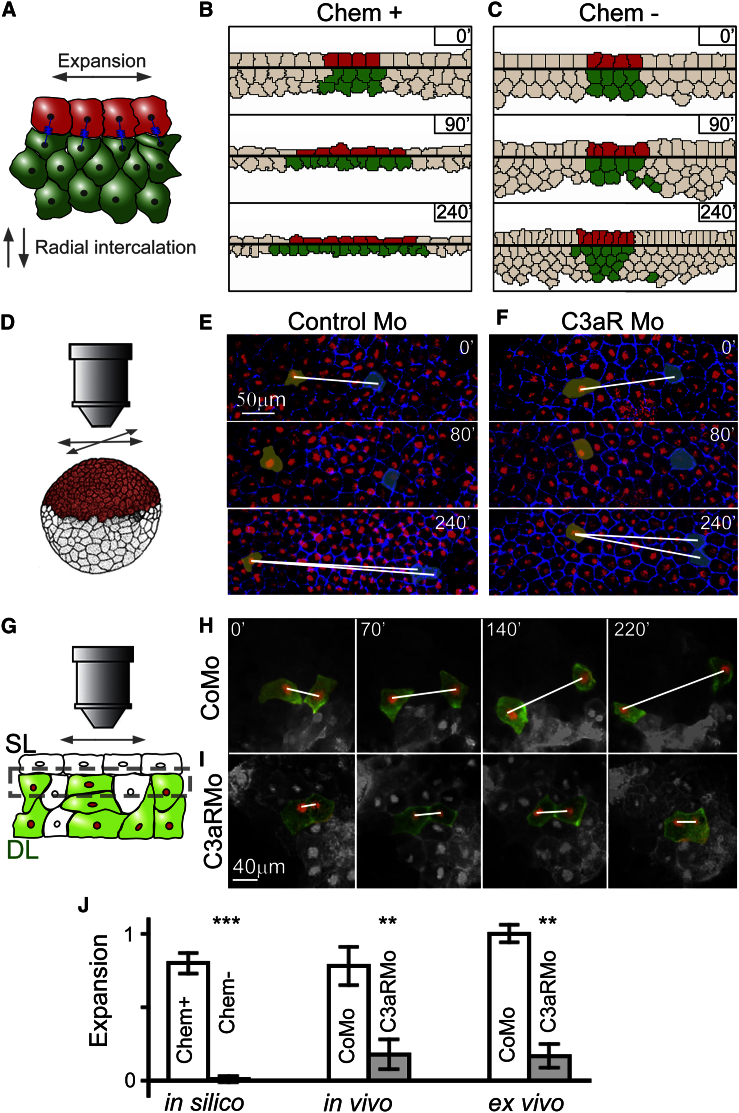
C3 Signaling Is Required for Epithelial Expansion(A–C) Model prediction of tissue expansion as a consequence of chemotaxis-driven RI. In the presence of chemotaxis, both the SL and DL expand simultaneously with RI (B, coloring for visual aid only), while no expansion is observed without chemotaxis (C).(D–F) Time-lapse imaging of epiboly in live embryos (D) reveals that while SCs drift away from one another following CoMo treatment (E), the distance of SCs in C3aR-deficient embryos does not increase (F) during the process.(G–I) Ex vivo study of tissue expansion using the intercalation assay (G). Cells in the DL separate as the isolated tissue undergoes expansion (H). This expansion is lost in tissues lacking C3aR (I).(J) Quantification of tissue expansions as the difference in the final and initial distances relative to the initial distance of tracked cell pairs in silico, in vivo, and ex vivo. Error, SD; significance, ∗∗p ≤ 0.01, ∗∗∗p < 0.001. See also Figure S7.